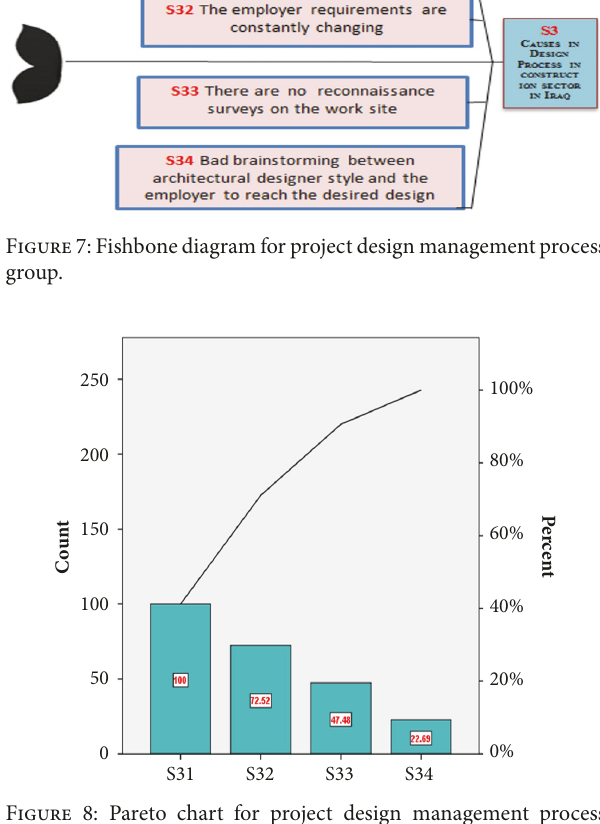
Figure 8: Pareto chart for project design management process group.